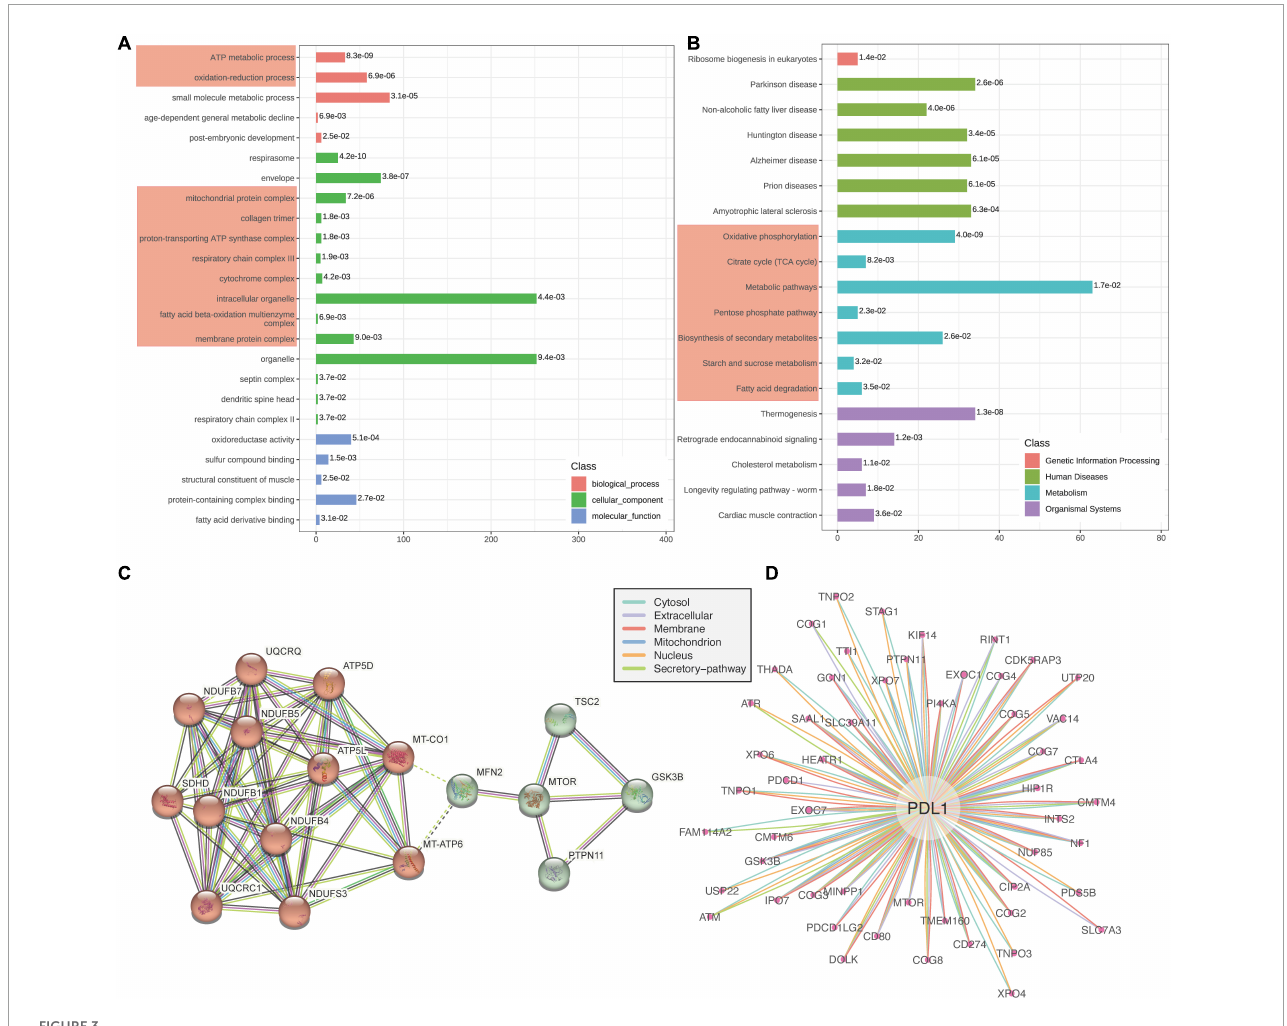
FIGURE3 Protein enrichment analysis and protein–protein interactions (PPIs). (A) Gene Ontology (GO) enrichment analysis of differentially expressed proteins. (B) Kyoto encyclopaedia of genes and genomes (KEGG) enrichment analysis of differentially expressed proteins. (C) PPI network. (D) PD-L1 subcellular organelle protein interaction